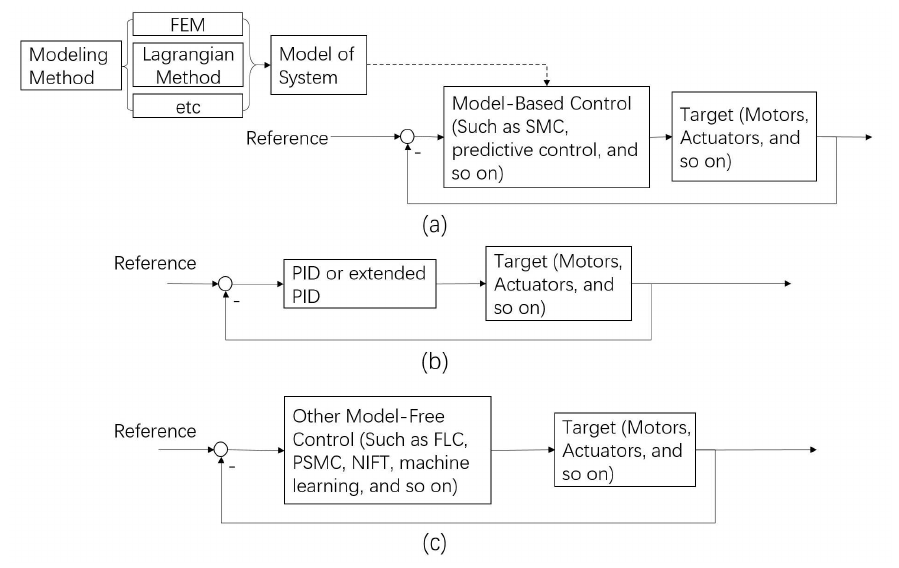
Figure 6. Three control strategies of SRNCRs. ( a ) Model-based control method; ( b ) PID or extended PID method; ( c ) Other model-free control